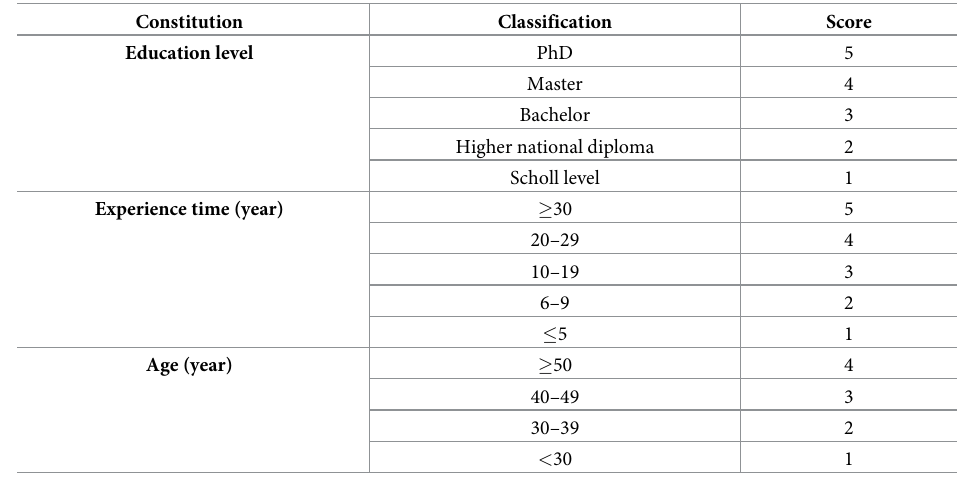
Table 12. Fraction of the different operators